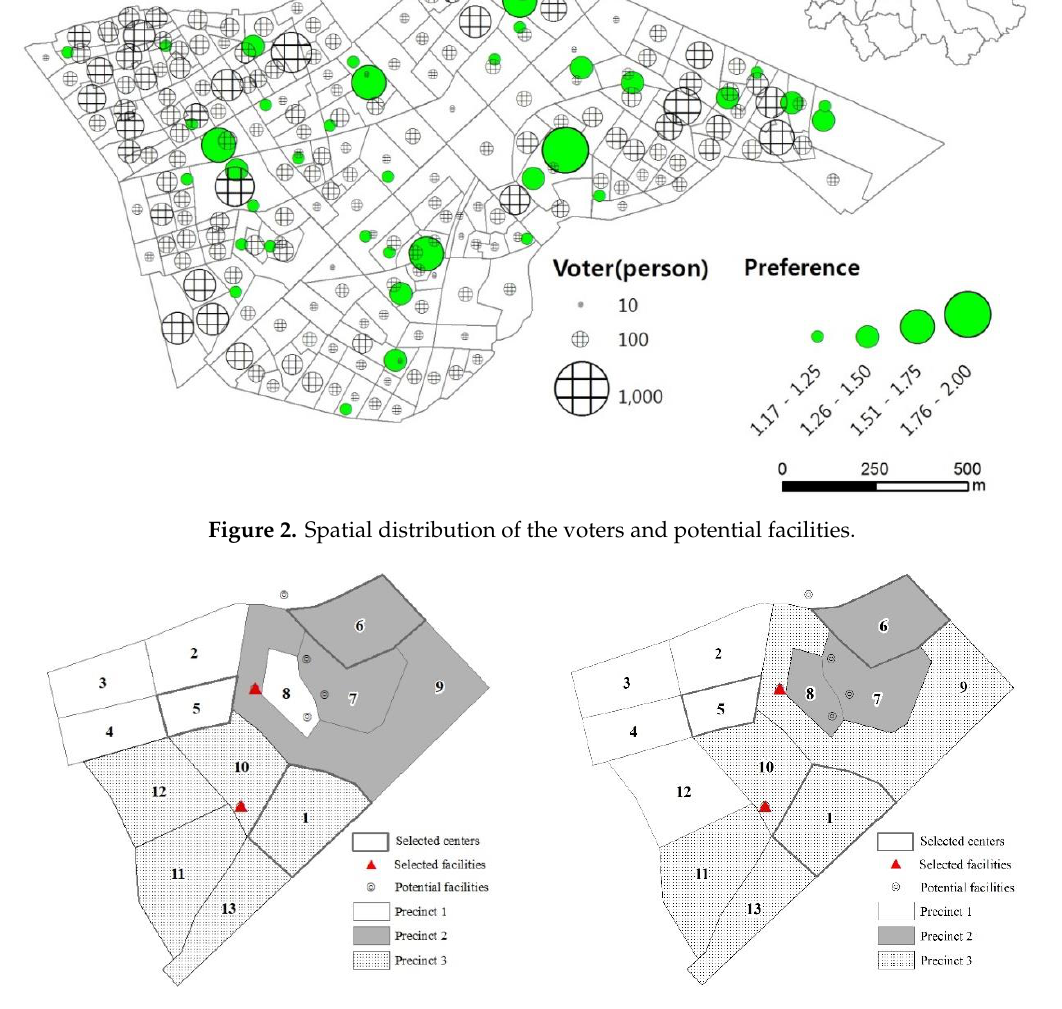
Table 1. Computational results for the small dataset ( n = 13, p = 3).